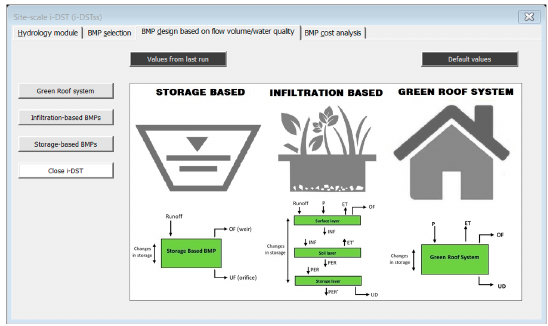
Figure A14. Output of BMP selection module.